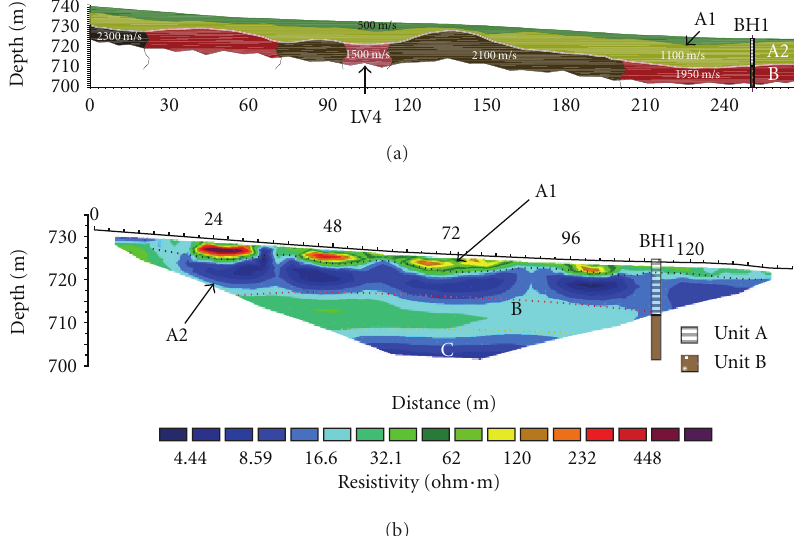
Figure 8: (a) Seismic refraction profile detects two layers of Unit A and the top of Unit B; LV indicates a low-velocity zone. (b) Electrical resistivity tomography profile detects Units A and B and a non drilled shale layer. LD indicates lateral discontinuity of marl formation. Profile locations appear in Figure